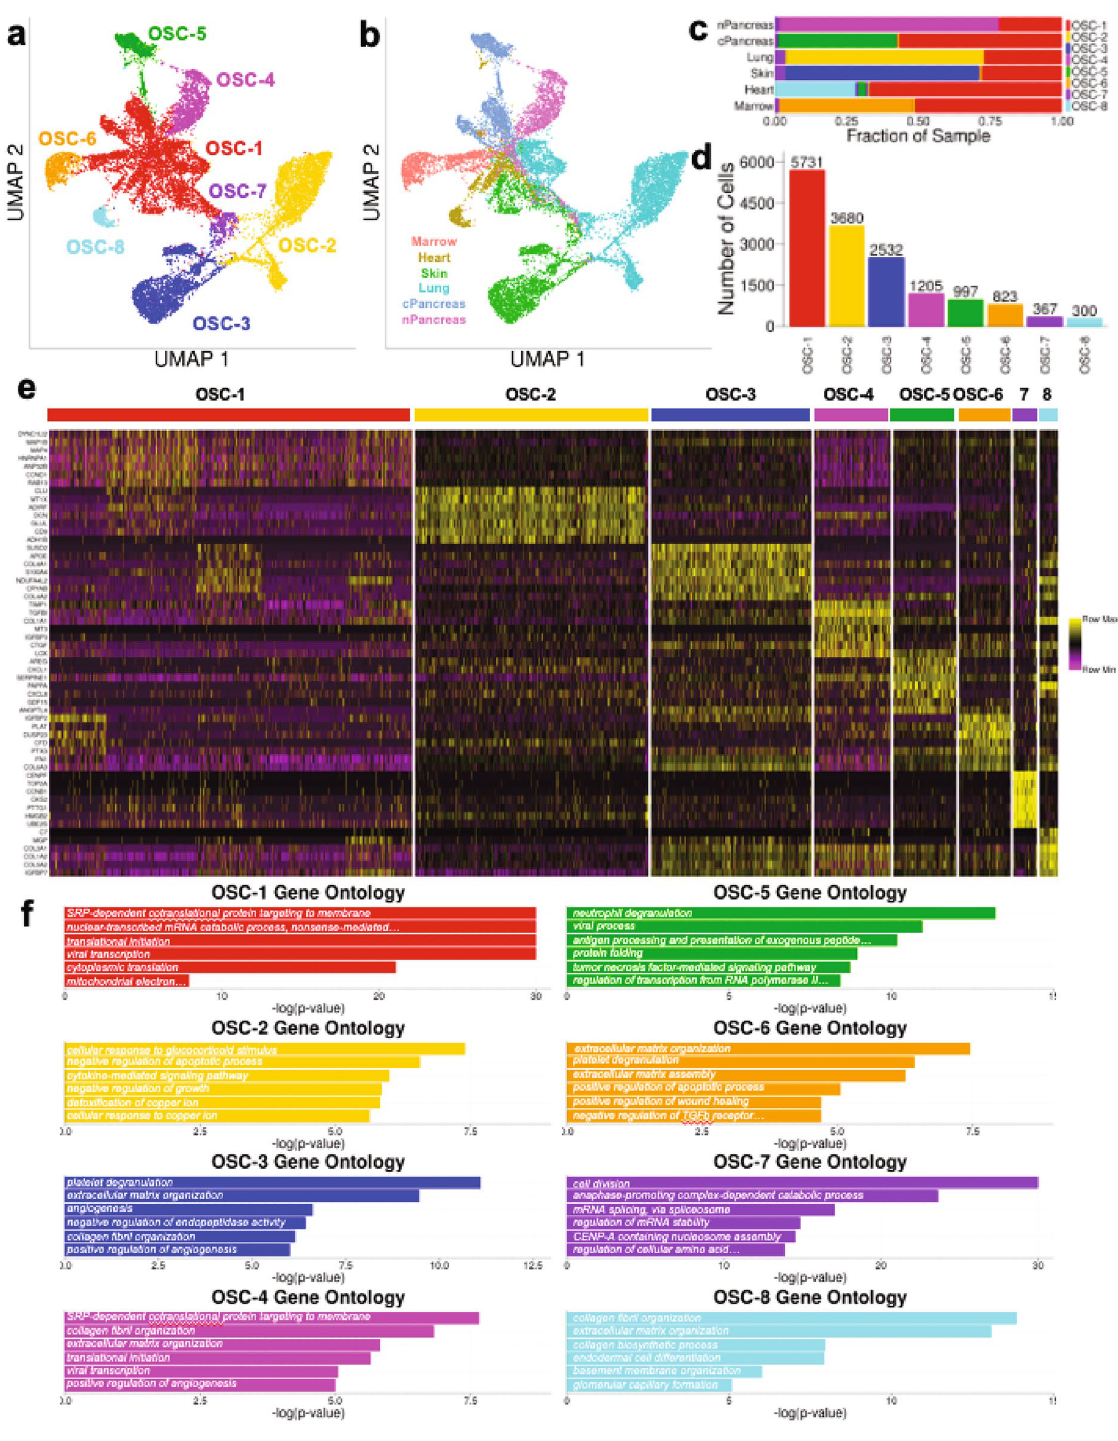
Figure 5. Stromal cells isolated from 3D in vitro microvessel networks separate into distinct clusters with unique transcriptomic profiles. ( a ) UMAP plot of renormalized OSCs from the 3D in vitro microvessel network dataset shows OSCs separate into 8 distinct clusters (OSC-1, OSC-2, OSC-3, OSC-4, OSC-5, OSC-6, OSC-7, and OSC-8). ( b ) UMAP plot of renormalized OSCs from the 3D in vitro microvessel network dataset grouped by 3D in vitro microvessel network type. ( c ) Grouped bar chart to show relative percentages of each OSC cluster per 3D in vitro microvessel network type. ( d ) Bar chart of total number of cells per OSC cluster. ( e ) Heatmap of top 7 DEGs for each OSC cluster. ( f ) Top 6 most significantly overexpressed GO biological process terms based on top 20 DEGs for each OSC